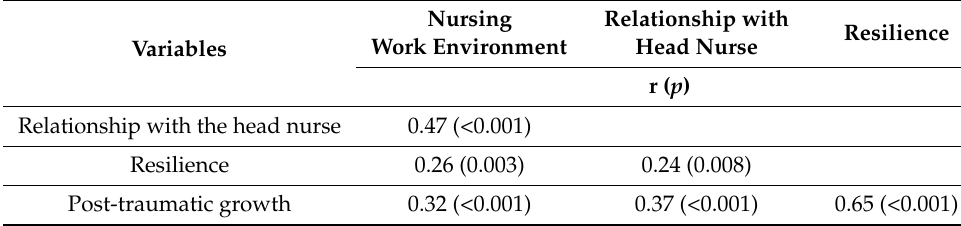
Table 4. Relationship between variables.